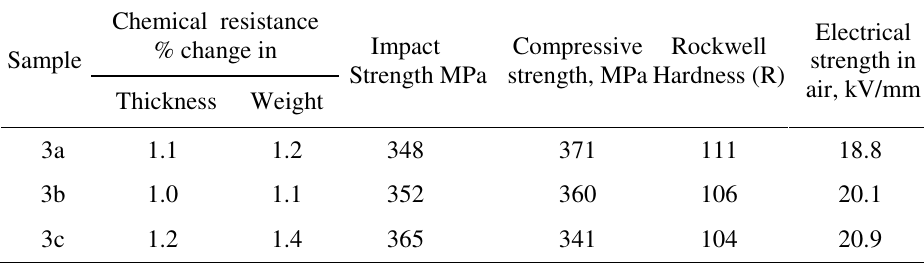
Table 4. Chemical, mechanical and electrical properties of glass reinforced composites of epoxy